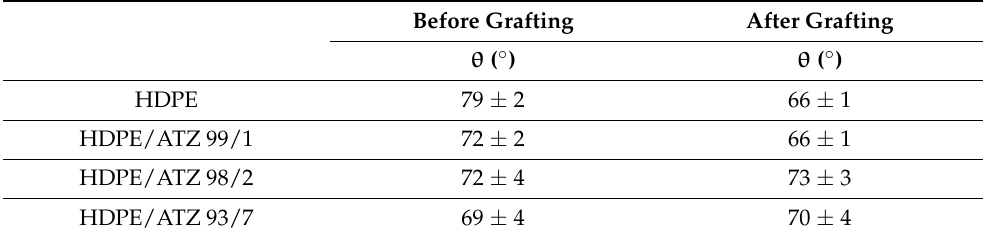
Table 3. Contact angle value (°) by sessile drop method for HDPE and HDPE/ATZ composites after electron-beam irradiation at 100 kGy and after chitosan functionalisation (reaction time= 3 h). Before Grafting